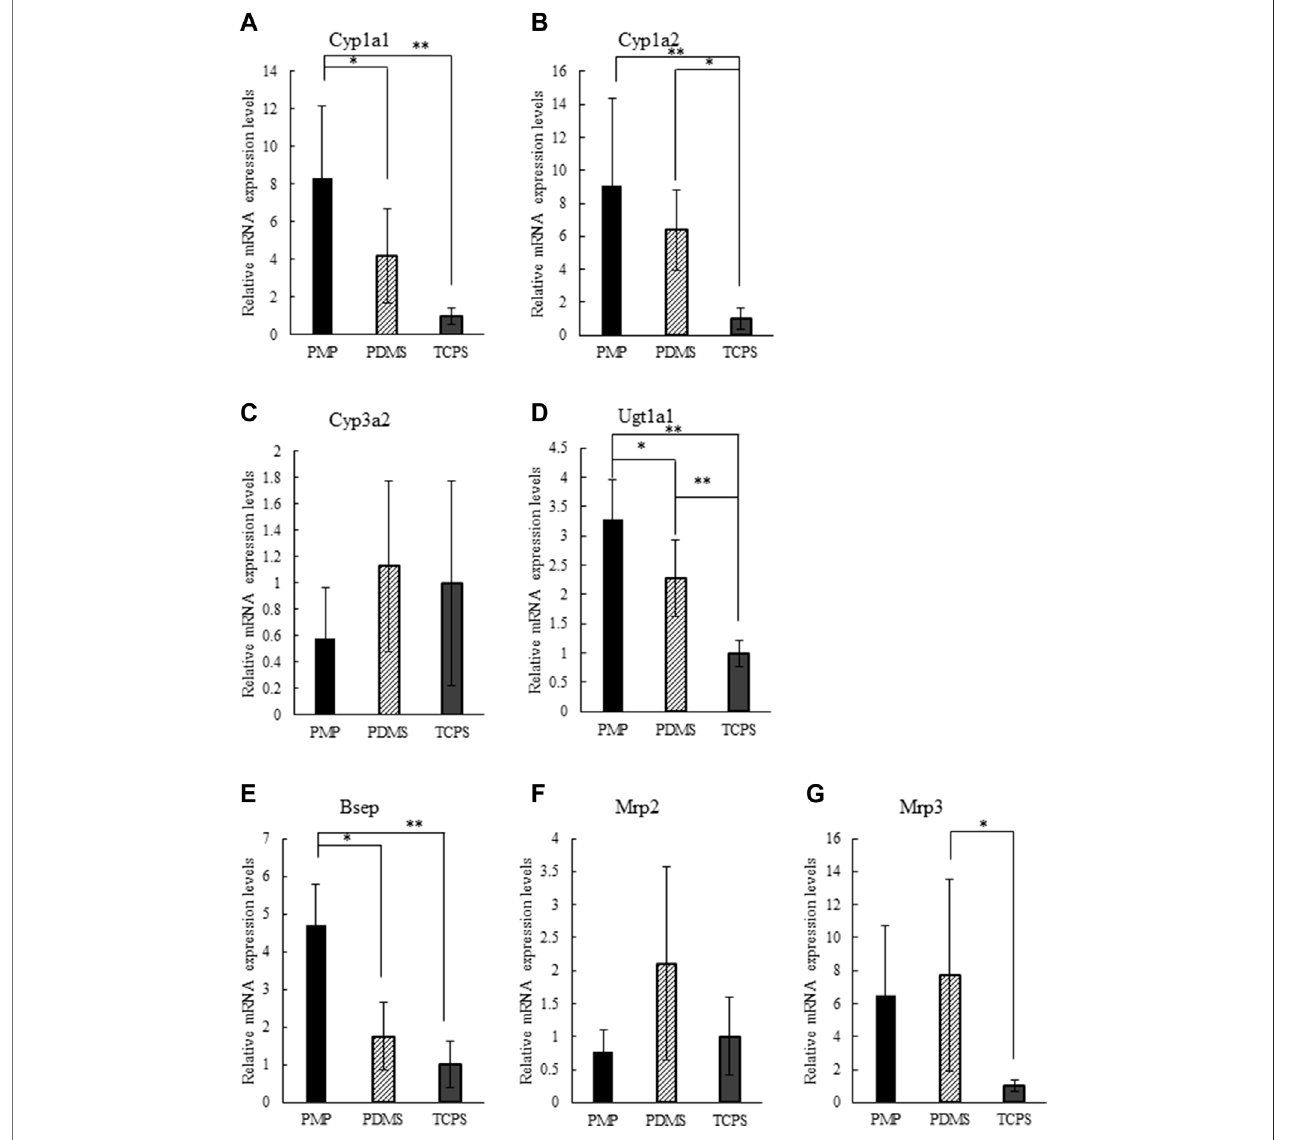
FIGURE 5 | Relative gene expression levels on day 7 normalized by TCPS condition: (A) Cyp1a1, (B) Cyp1a2, (C) Cyp3a2, (D) Ugt1a1, (E) Bsep, (F) Mrp2, (G) Mrp3 (*: p < 0.1, **: p < 0.01, N = 6).